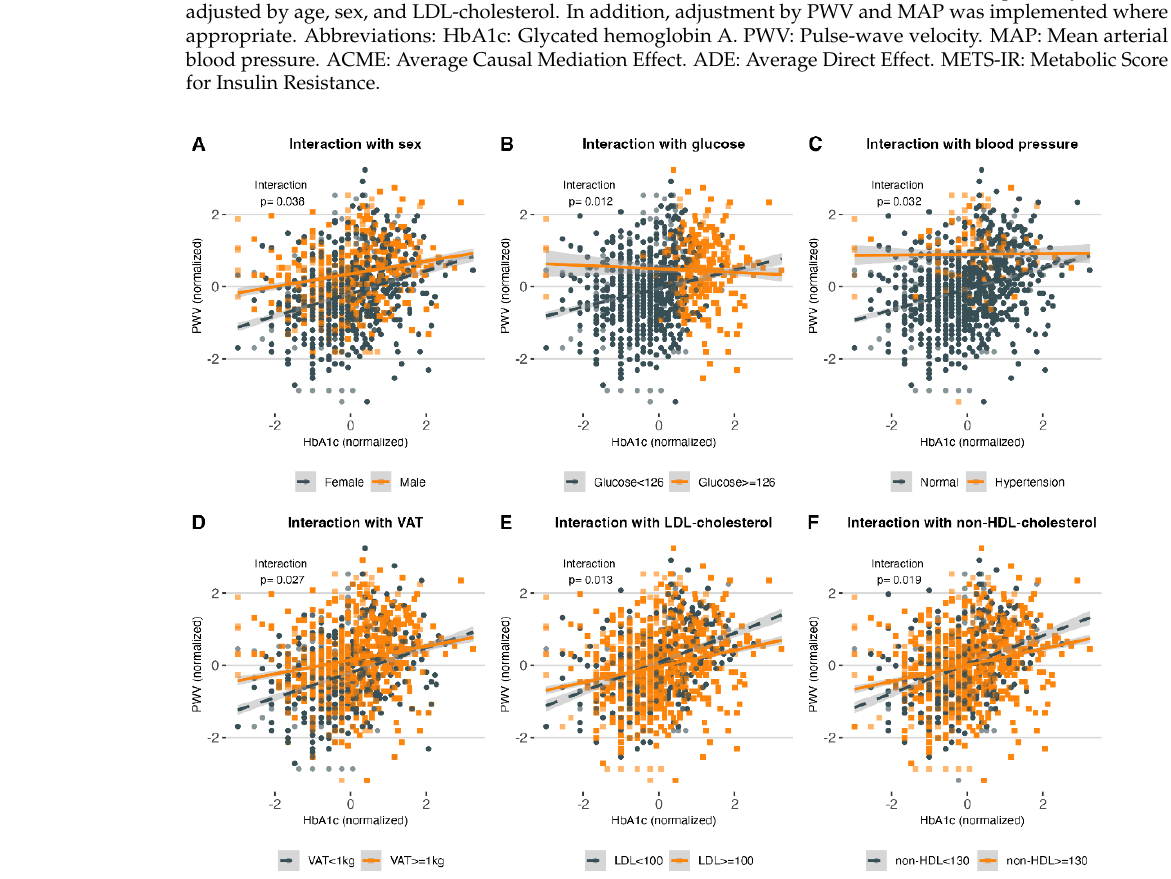
Figure 3. ( A – F ) show the interactions of sex, FGP, blood pressure, VAT, LDL-C, and non-HDL-C with HbA1c and PWV, respectively. The linear relationship between HbA1c and PWV is modified by sex, FGP ≥ 126 mg/dL, hypertension (SBP ≥ 140 mg/dL or DBP ≥ 90 mg/dL), visceral